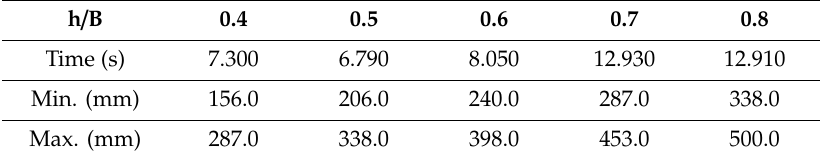
Figure 10. Comparison of fluid surface shape from ratio of initial fluid height to structure width. Table 5. Maximum and minimum sloshing height according to h / B.